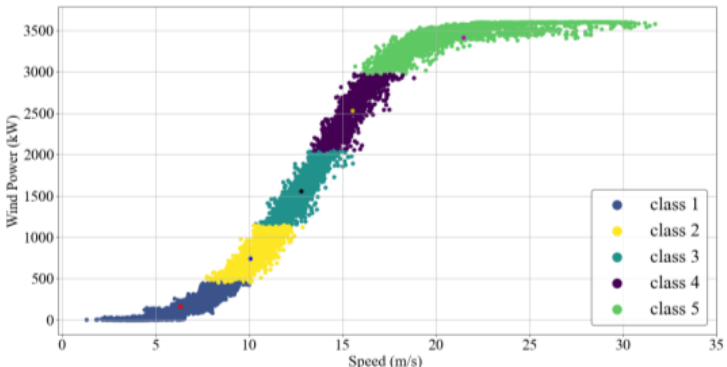
Figure 10. Wind power data classification using a k-means method.